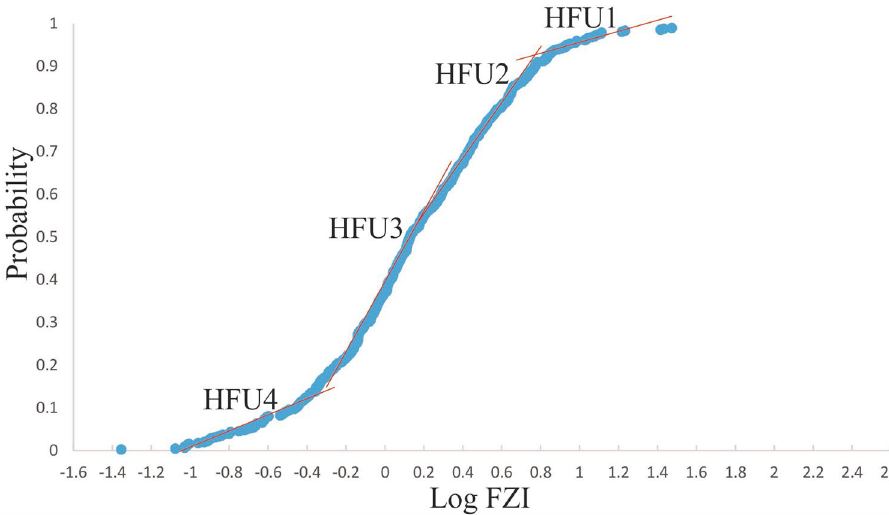
Fig. 8 Probability plot of FZI reflects four hydraulic flow units in the studied wells